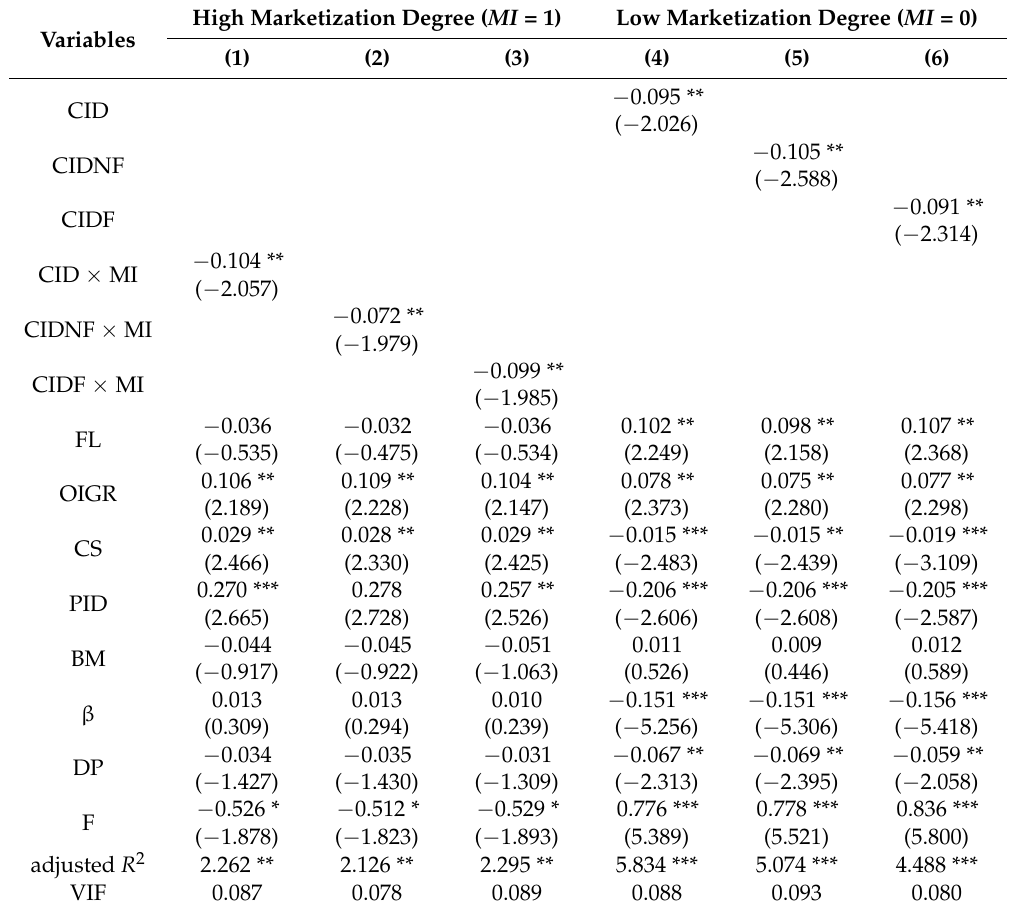
Table 5. Regression analysis of marketization degree, carbon information disclosure, and cost of equity